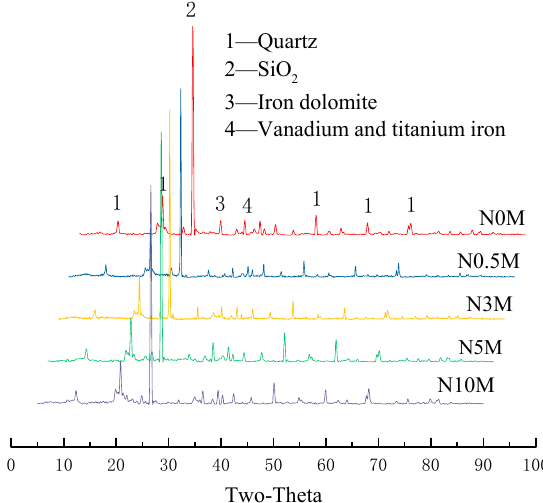
Figure 1. X-ray diffraction spectra of lignite and nitric acid-modified lignite.